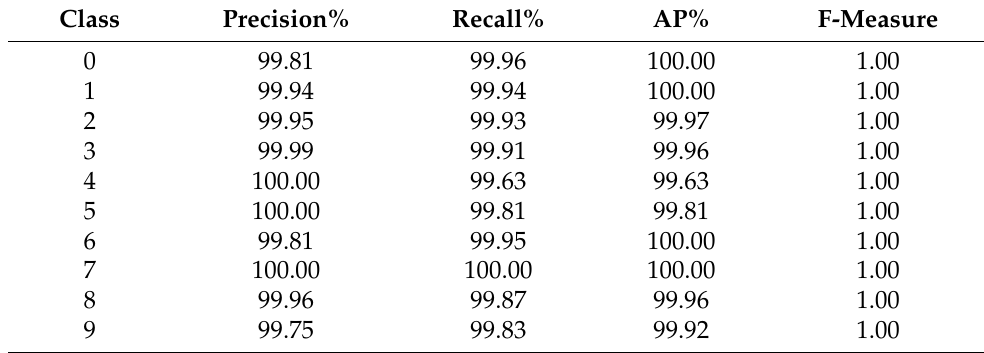
Table 4. Performance Indicators For Each